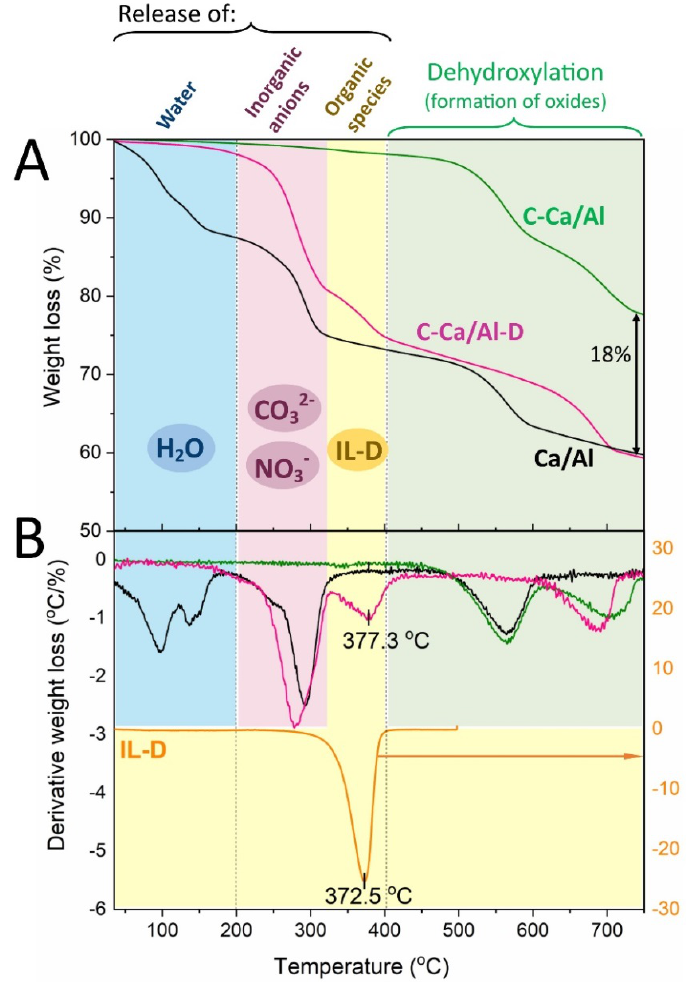
Figure 2. TGA ( A ) and DTG ( B ) curves of pristine LDH (Ca / Al), calcinated LDH (C-Ca / Al), calcinated LDH modified with IL-D (C-Ca / Al-D) and pure ionic liquid (IL-D).